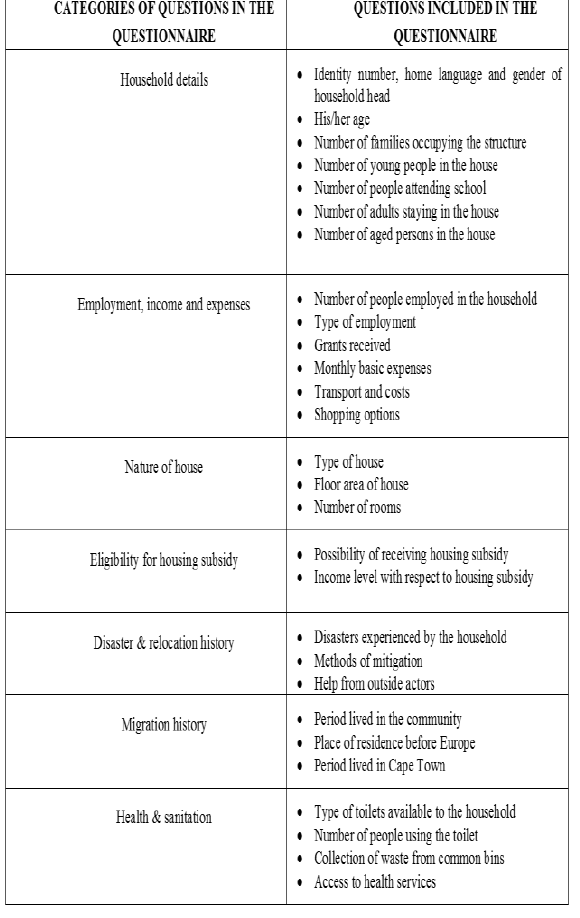
Table 1. Sections of the questionnaire (Musungu 2012: 41). The choice of questions included a number of issues ranging